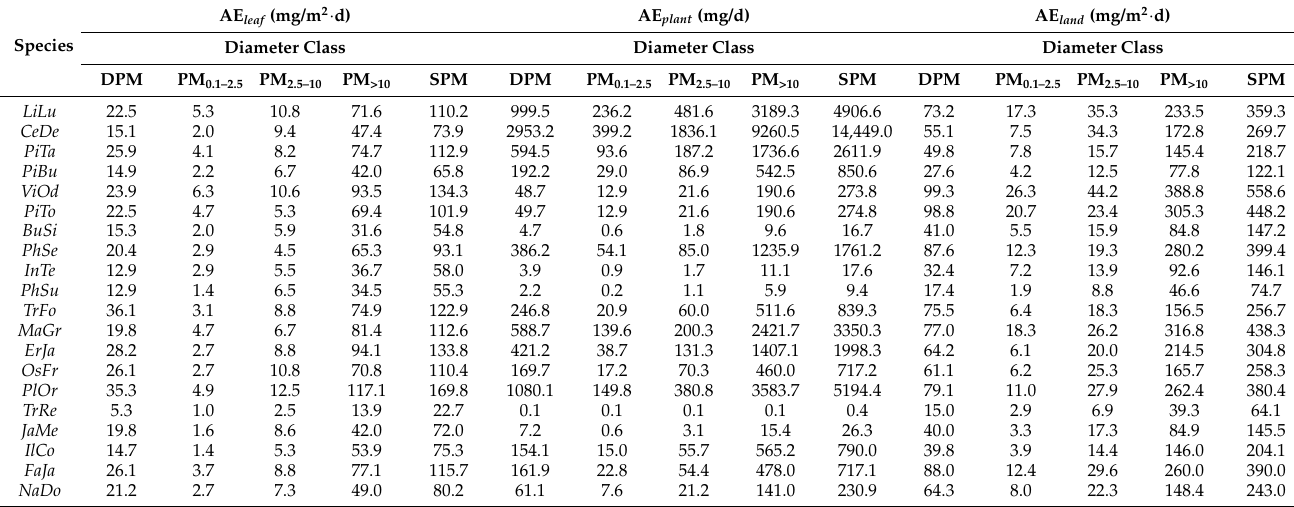
Table 1. The retention efficiency (AE) of the investigated plant species in retaining surface PM (SPM) within different diameter classes (particle diameter > 10 µ m, 2.5–10 µ m, 0.1–2.5 µ m) and water-soluble PM (DPM).